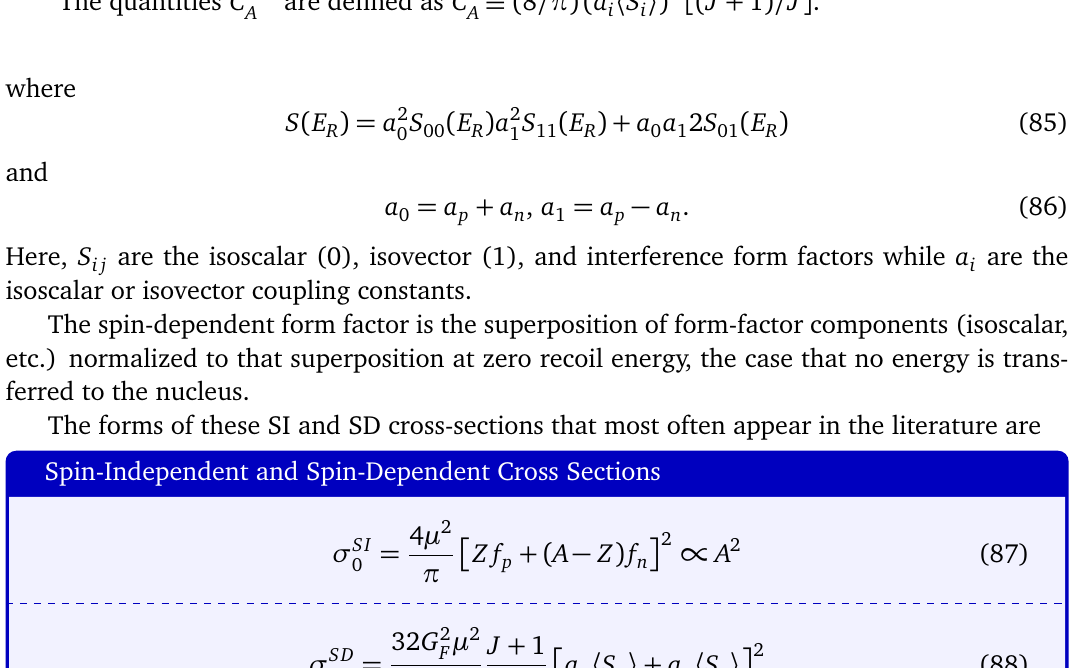
Figure 5: From Ref. [ 13 ] , this table provides values for terms that appear in Eqn. 88. The quantities C p , n